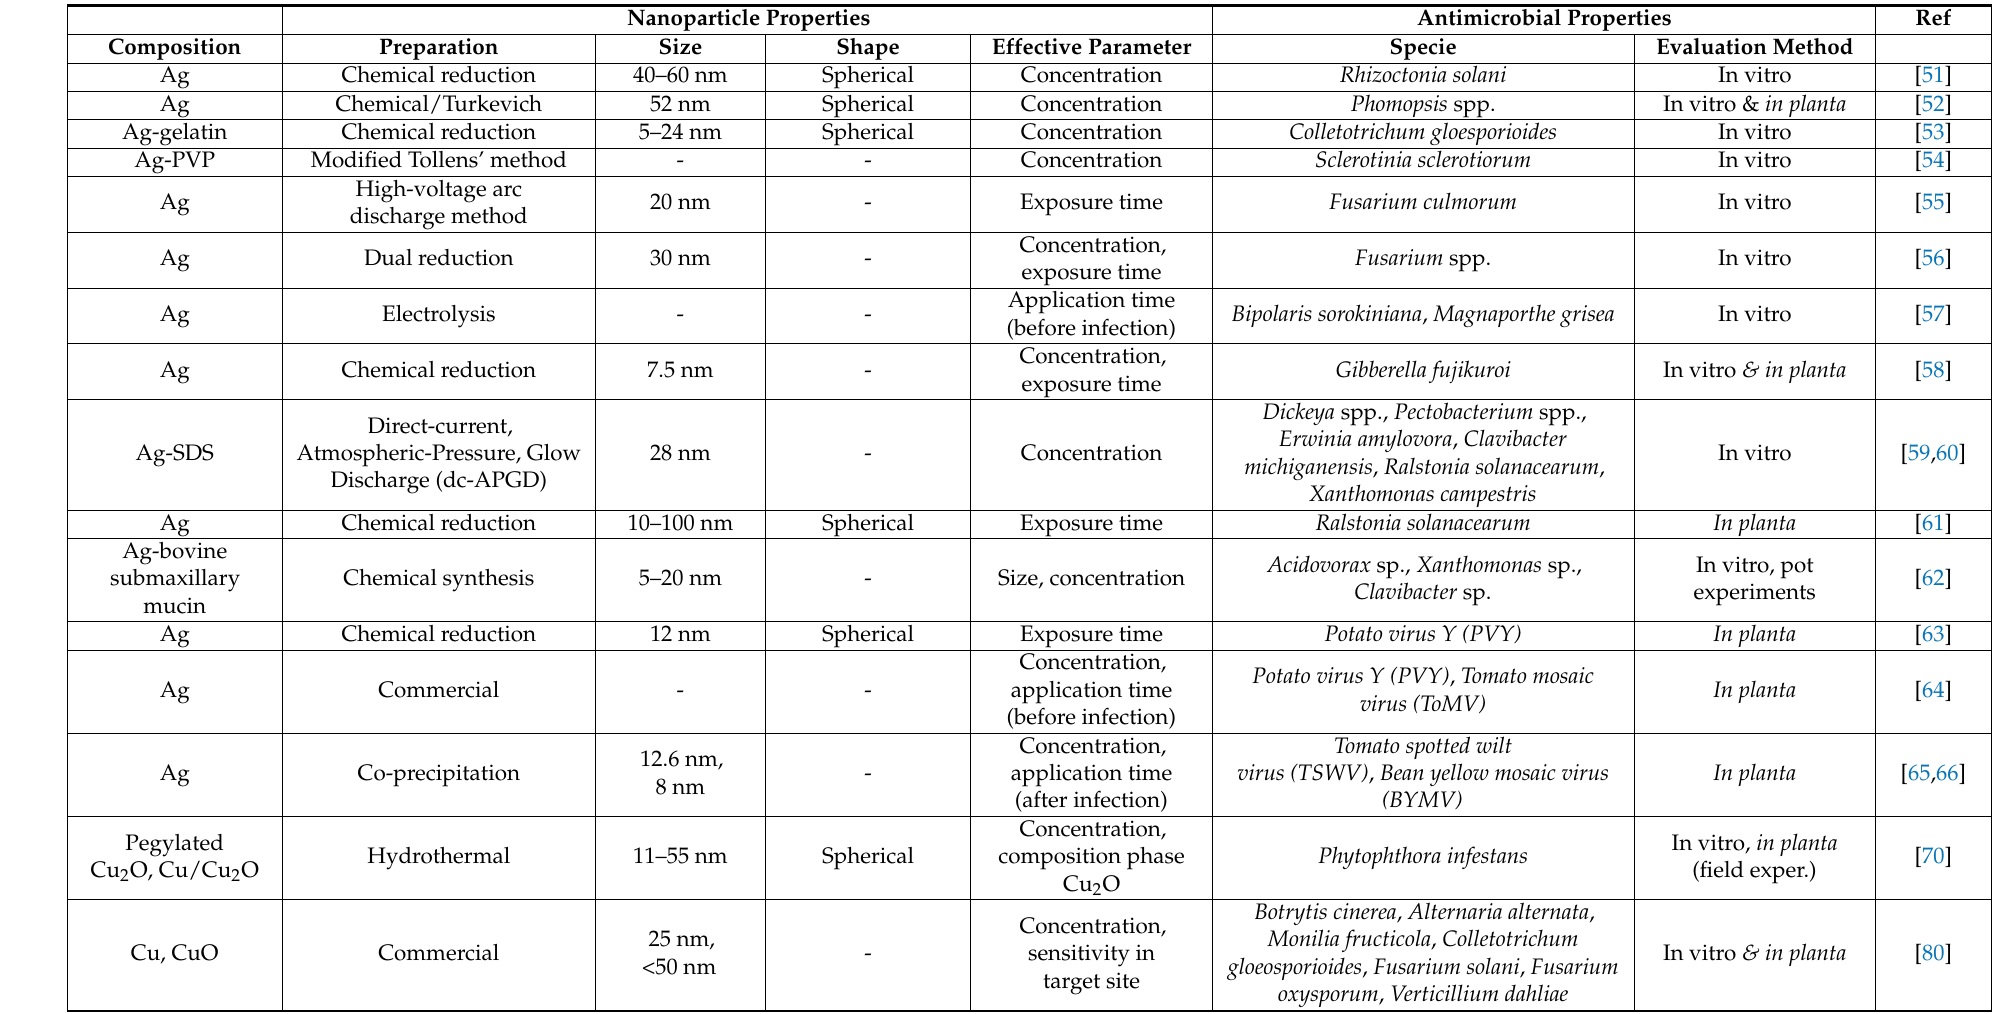
Table 1. Summary of engineered INPs against classified species (bacteria, fungi,